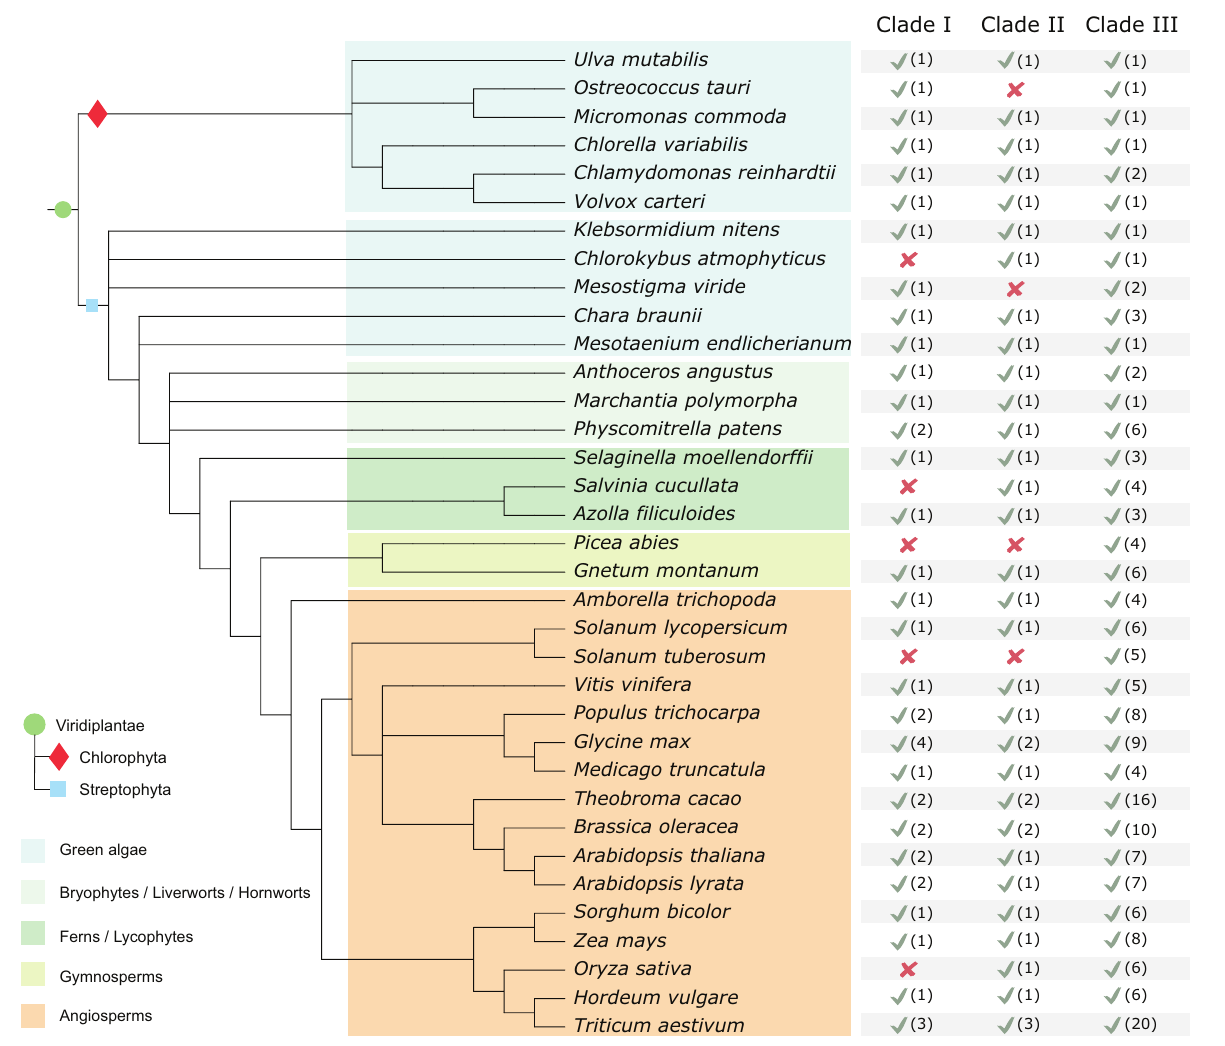
FIGURE 3 | Summary of MAP4K family occurrence in the green lineage. Table based on the results of the inferred MAP4K phylogenetic tree within selected species. √ The presence ( ) (and the number of MAP4Ks) or absence (x) of a likely functional ortholog are indicated. It should be noted that for those with missing clades, this can also be due to an incomplete